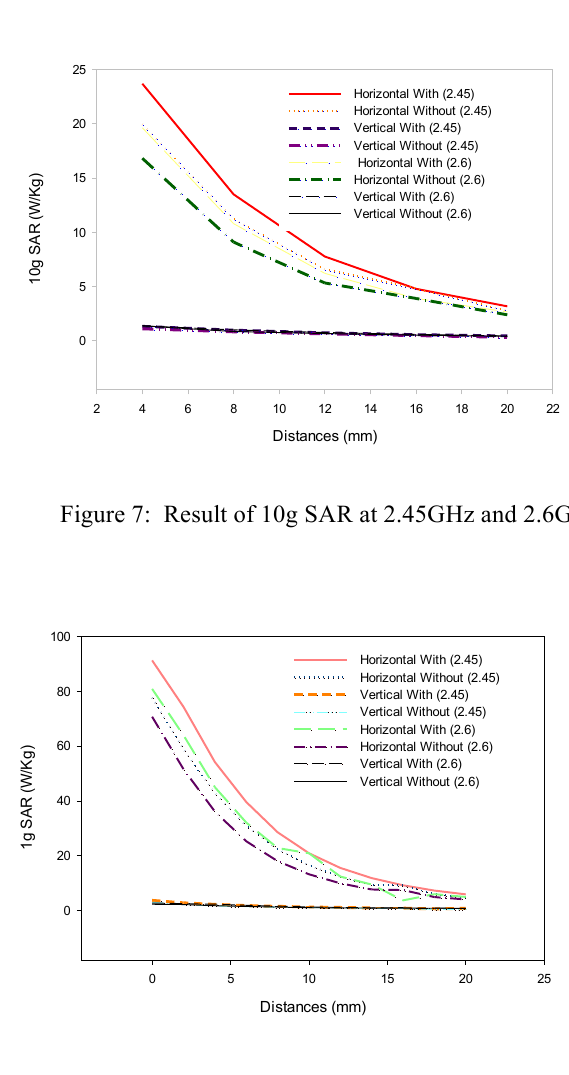
Figure 8: Result of 1g SAR at 2.45GHz and